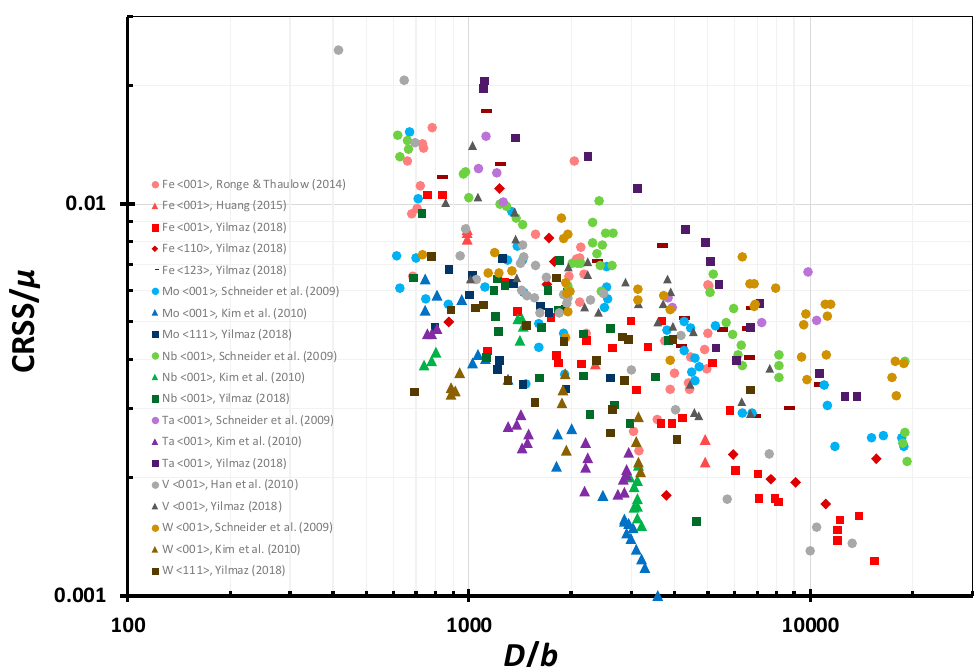
Figure 4. Variation of the critical resolved shear stress normalized by the shear modulus versus the sample diameter normalized by the Burgers vector in BCC metals. The original experimental data is reported by Schneider et al. [39], Kim et al. [40], Han et al. [41], Rogne and Thaulow [42], Huang et al. [43], and Yilmaz [44].